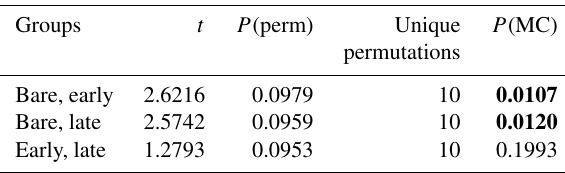
Table 4. Permutational analysis of variance (PERMANOVA) of pair-wise comparisons of Bray–Curtis dissimilarity between biocrust stages and bare soil. P (MC): probability values obtained using 9999 Monte Carlo permutations. A test for homogeneity of multivariate dispersions (PERMDISP) showed no significant differ- ences in variation for the spread of samples (pseudo- F = 3 . 8068, P (perm) = 0.068). Significant pair-wise differences are in bold.